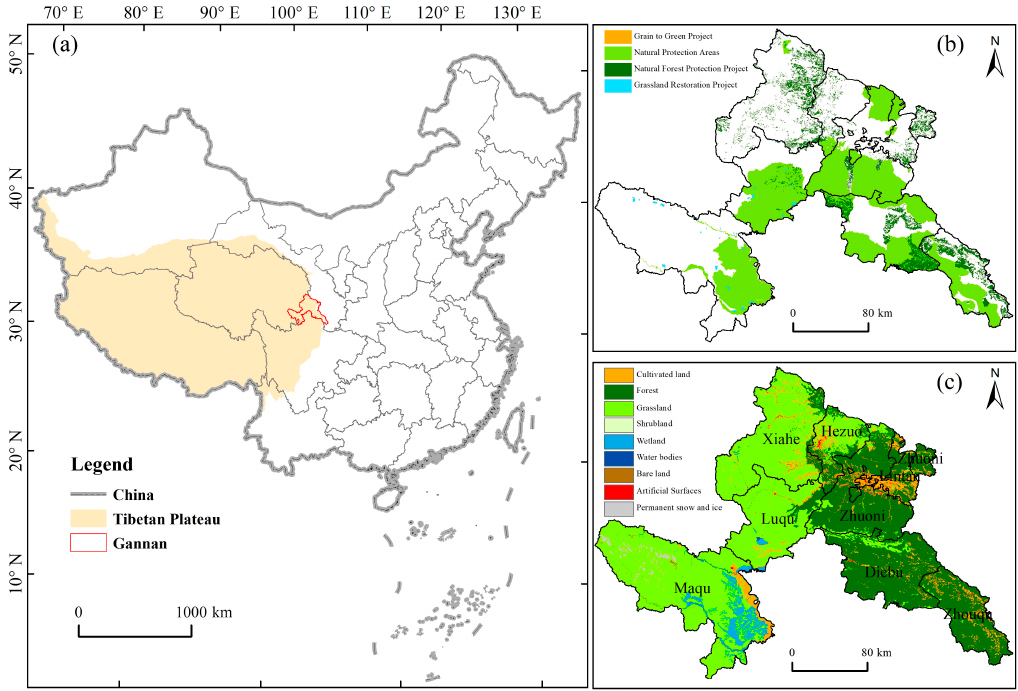
Figure 1. Location of Gannan Prefecture ( a ) and spatial distribution of various ecological protection and restoration projects ( b ), and land cover types ( c